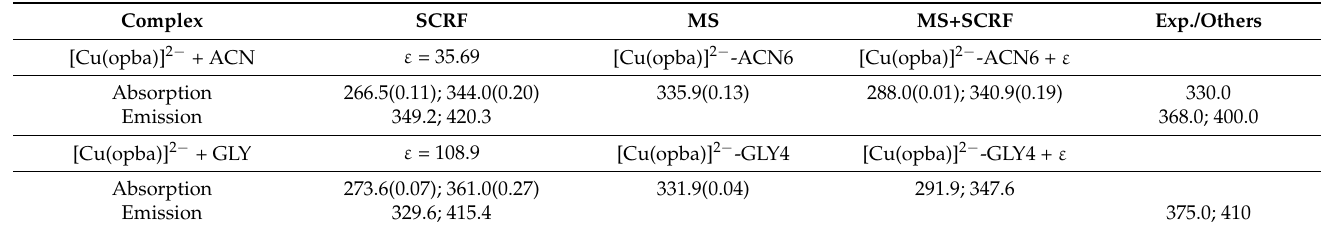
Figure 9. TDDFT emission spectrum of solvated [Cu(opba)] 2 − in ( a ) ACN, ε = 35.69. Inset shows emission spectra for excitations at a given λ ; ( b ) in formamide, ε = 108.9. Table 2. [Cu(opba)] 2 − absorption and emission energies (in nm).